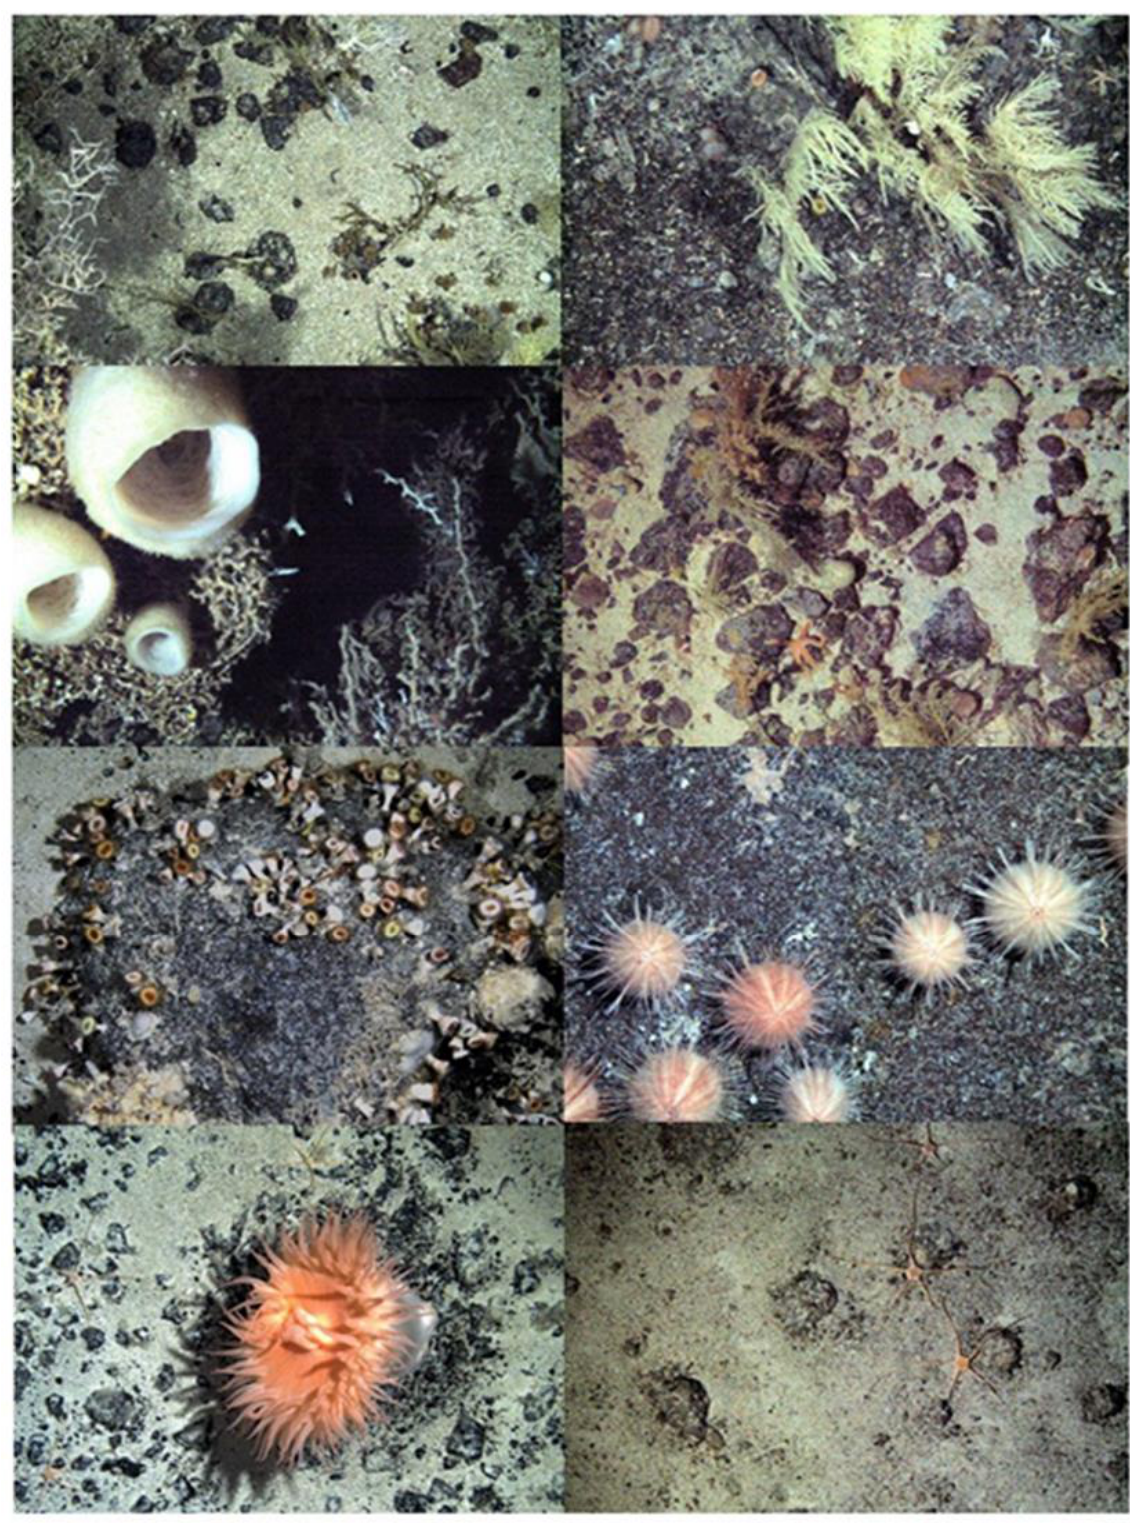
Figure 3. Shelf Underwater Camera System images of seabed around Tristan da Cunha’s islands and seamounts showing variability in benthic assemblages (and carbon storage).